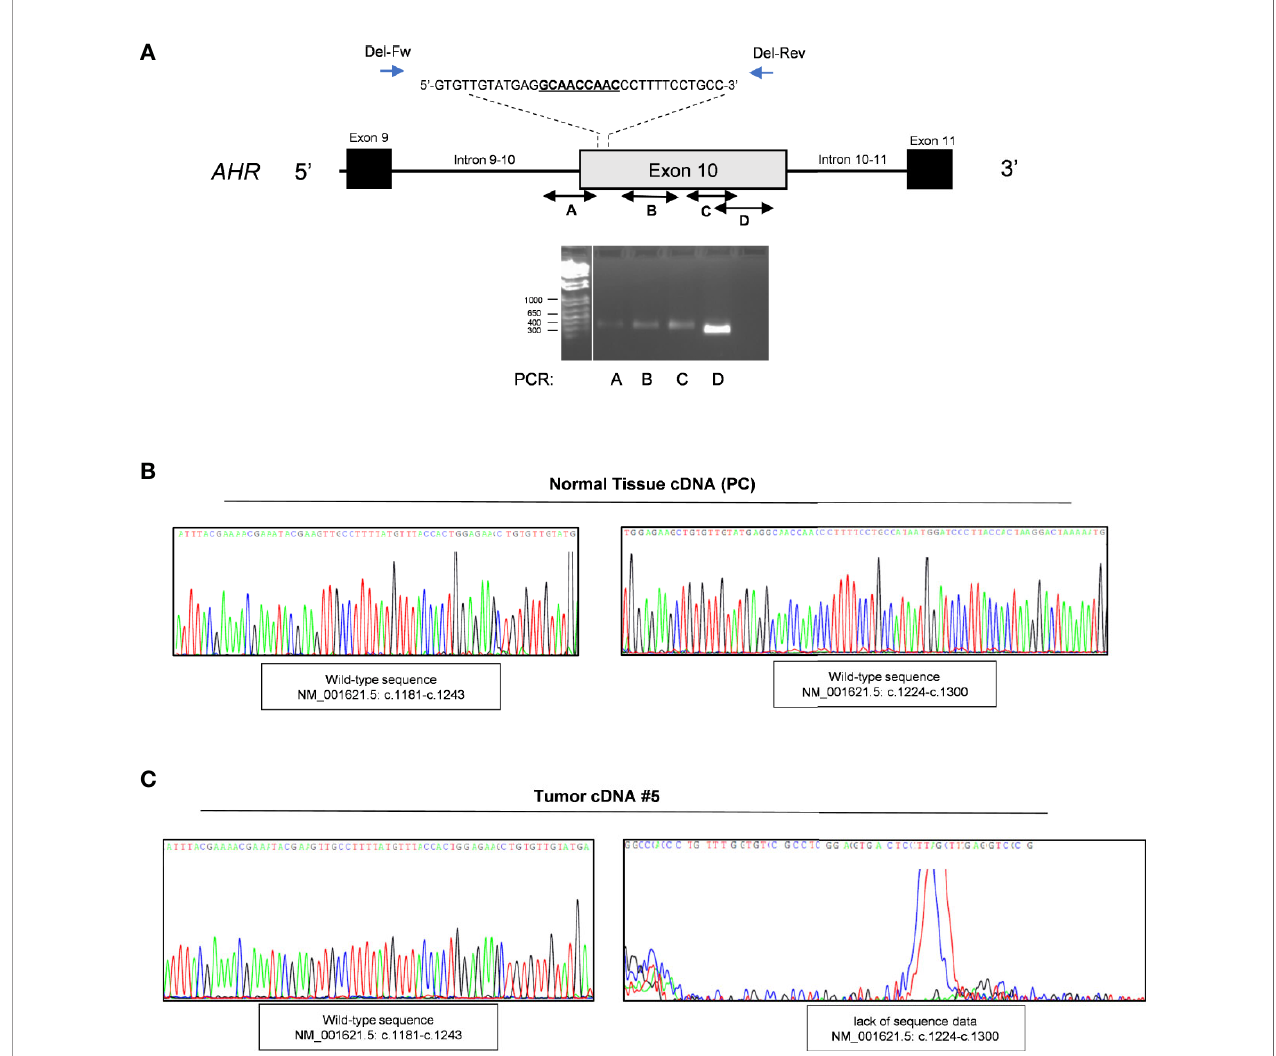
FIGURE 2 | Validation of in frame somatic deletion on tumor DNA. (A) Schematic image of the human aryl hydrocarbon receptor ( AHR ) gene structure and localization of in frame deletion. Double-headed arrow lines identify the regions A – D ampli fi ed by PCR; single arrow lines identify primers used to amplify deletion region. Representative PCR for AHR exon 10 regions of tumor DNA of patient #5. The leftmost lane contains DNA ladder (1kb plus). Lane 2 shows PCR product of exonic region upstream the variant rs764425858 (PCR#A). Lane 3 shows PCR product of exonic region downstream the variant rs764425858 and upstream the variant rs760349720 (PCR#B). Lane 4 shows PCR product of exonic region downstream variants rs760349720 and rs760349720 and upstream the variant rs778350893 (PCR#C). Lane 5 shows PCR product of exonic region between the variants rs760349720 and rs778350893 (PCR#D). White lines indicate PCR products run in non-contiguous lanes of the same gel. (B, C) Representative sequence analysis on cDNA after ampli fi cation of AHR exon 9 and 10 in healthy pituitary sample (B) and tumor samples (patient #5) (C) . Left panel shows electropherogram with a focus on the ampli fi ed region c.1027-c.1243 (PCR of exon 9 and upstream exon 10, before deletion site; c.1181-c.1243). Right panel shows electropherogram with a focus on the ampli fi ed region c.1224-c.1243 (PCR of exon 9 and upstream exon 10, after deletion site